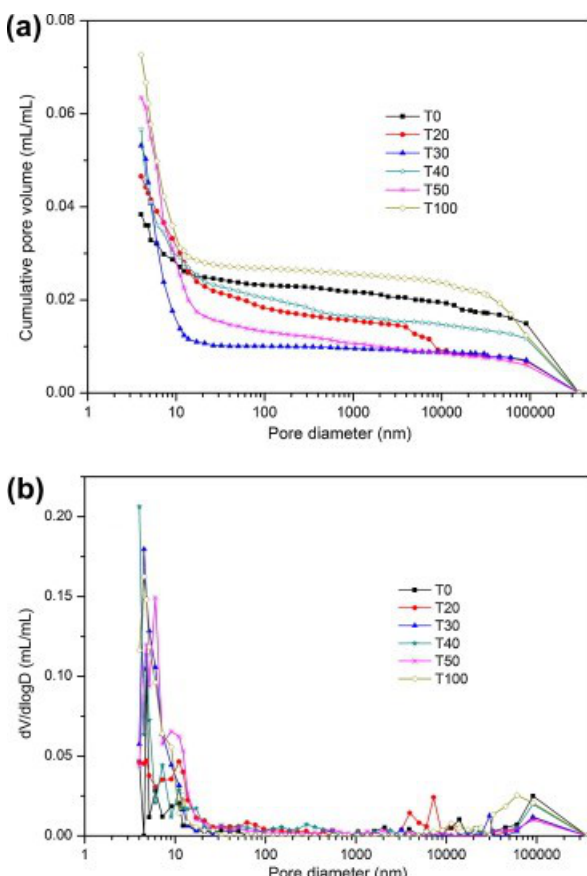
Figure 7: Water absorption and porosity results [36]